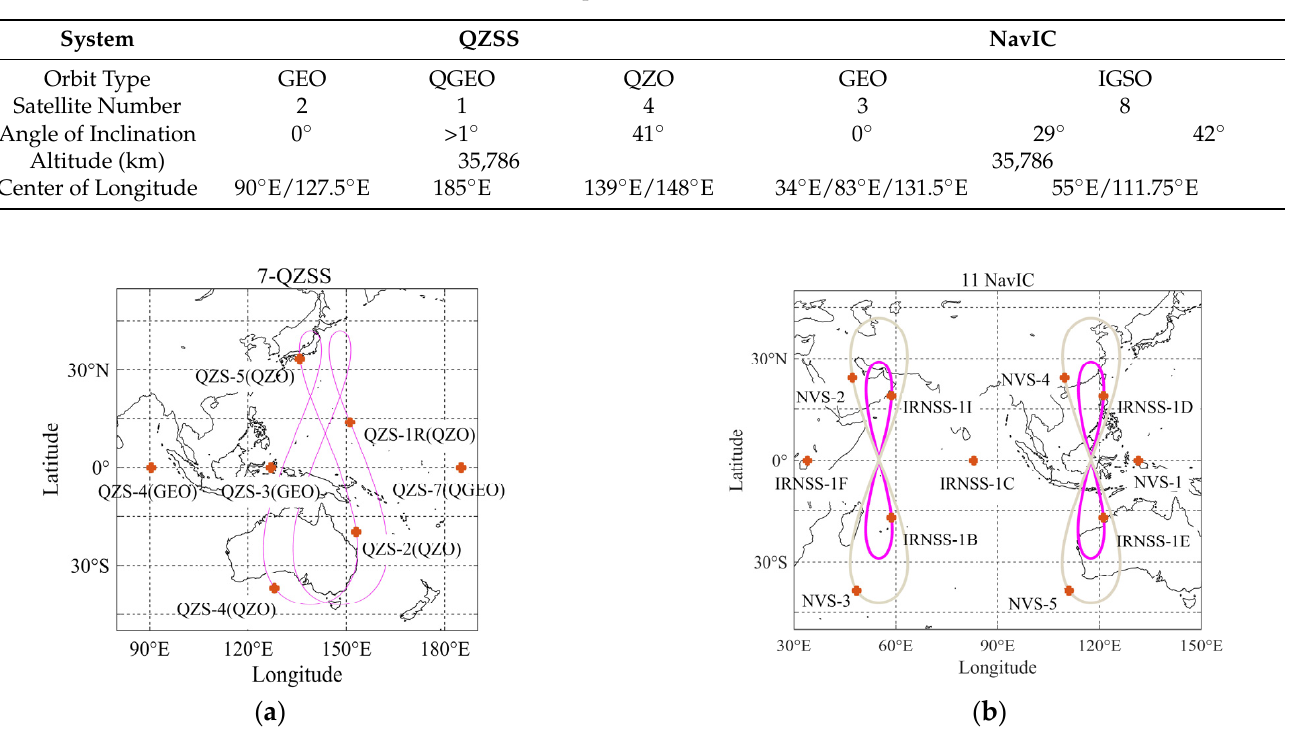
Table 6. Constellation parameters of QZSS and NavIC.